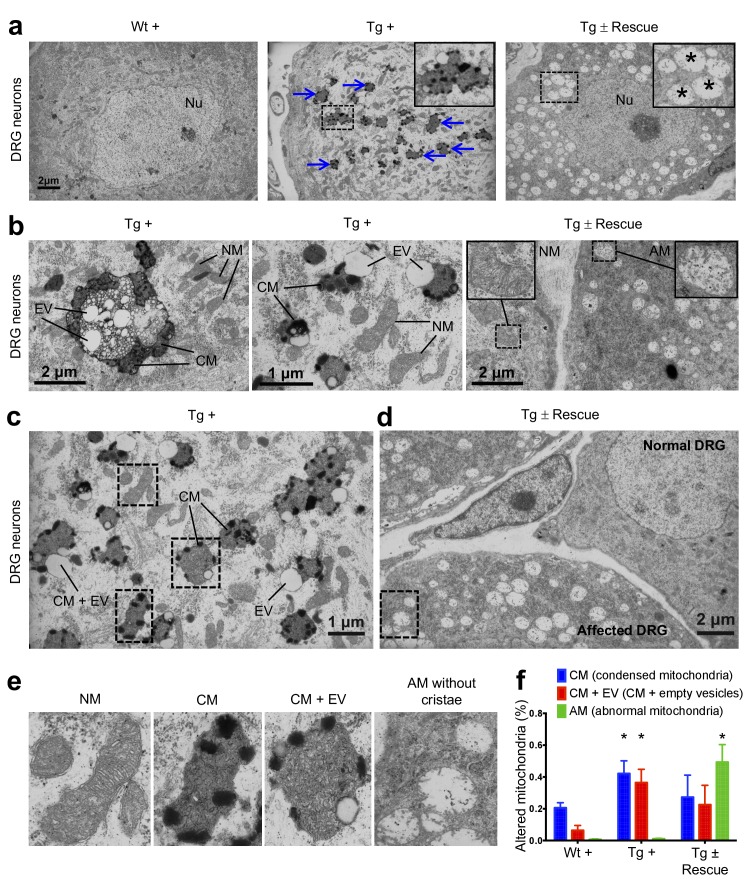
Frataxin knockdown mice exhibit neuronal degeneration.(a) Electron microscopic analysis of Wt +, Tg + and Tg ± rescue animal DRG neurons at 20 week after dox treatment. Arrows indicate condensed mitochondria with empty vesicles. Insert in Tg + panel shows higher magnification of electron micrographs of condensed mitochondria with empty vesicles in DRG neurons. Insert in Tg ± Rescue panel shows higher magnification of abnormal mitochondria without cristae (asterisks). Nu = nucleus. (b) Higher magnification of electron micrographs of Tg + and Tg ± Rescue animal DRG neurons at 20 week after dox treatment. Tg + panel shows degenerating mitochondria and condensed mitochondria with empty vesicles in DRG neurons. Tg ± Rescue panel shows two DRG neurons, one consisting of normal mitochondria (insert) and the other neuron with abnormal mitochondria without cristae (insert). (c) Higher magnification of Tg + animals showing condensed mitochondria with empty vesicles in DRG neurons. (d) Higher magnification of Tg ± rescue animals showing two DRG neurons, one consisting of normal mitochondria (normal DRG) and the other neuron with abnormal mitochondria without cristae (affected DRG). (e) Insert images from c and d panels shows higher magnification of normal mitochondria (NM), condensed mitochondria (CM), condensed mitochondria along with empty vesicles (CM + EV), and abnormal mitochondria without cristae (AM). (f) Quantification of altered mitochondria in DRG neurons. Data are from multiple images from three biological replicates per group. Values represent mean ± SME. Two-way ANOVA test *=P ≤ 0.05.10.7554/eLife.30054.017Figure 5—source data 1.This spreadsheet contains the manual mitochondrial counting data from electron microscopy images of the DRG neurons which was used to generate the graph shown in Figure 5f after frataxin knockdown in FRDAkd and control animals.